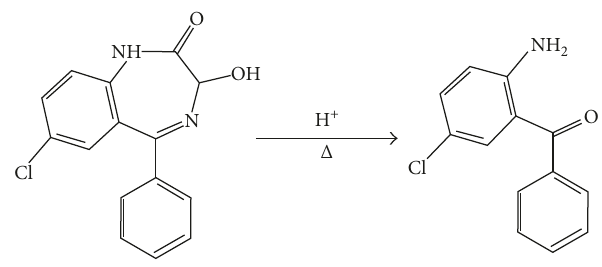
Figure 1: Oxazepam acid hydrolysis